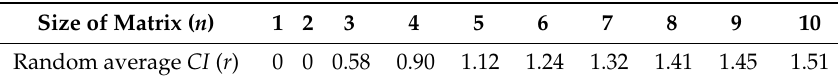
Table 3. Values of consistency indices ( CIs ).